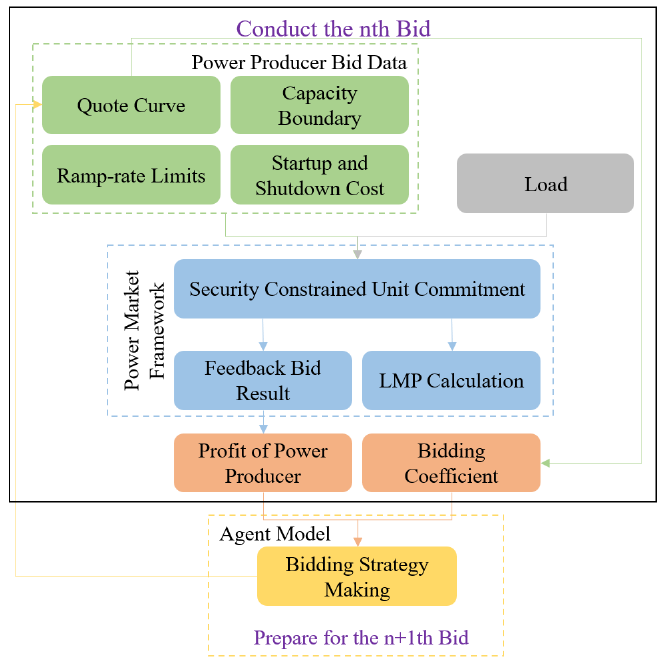
Figure 1. The proposed simulation framework.